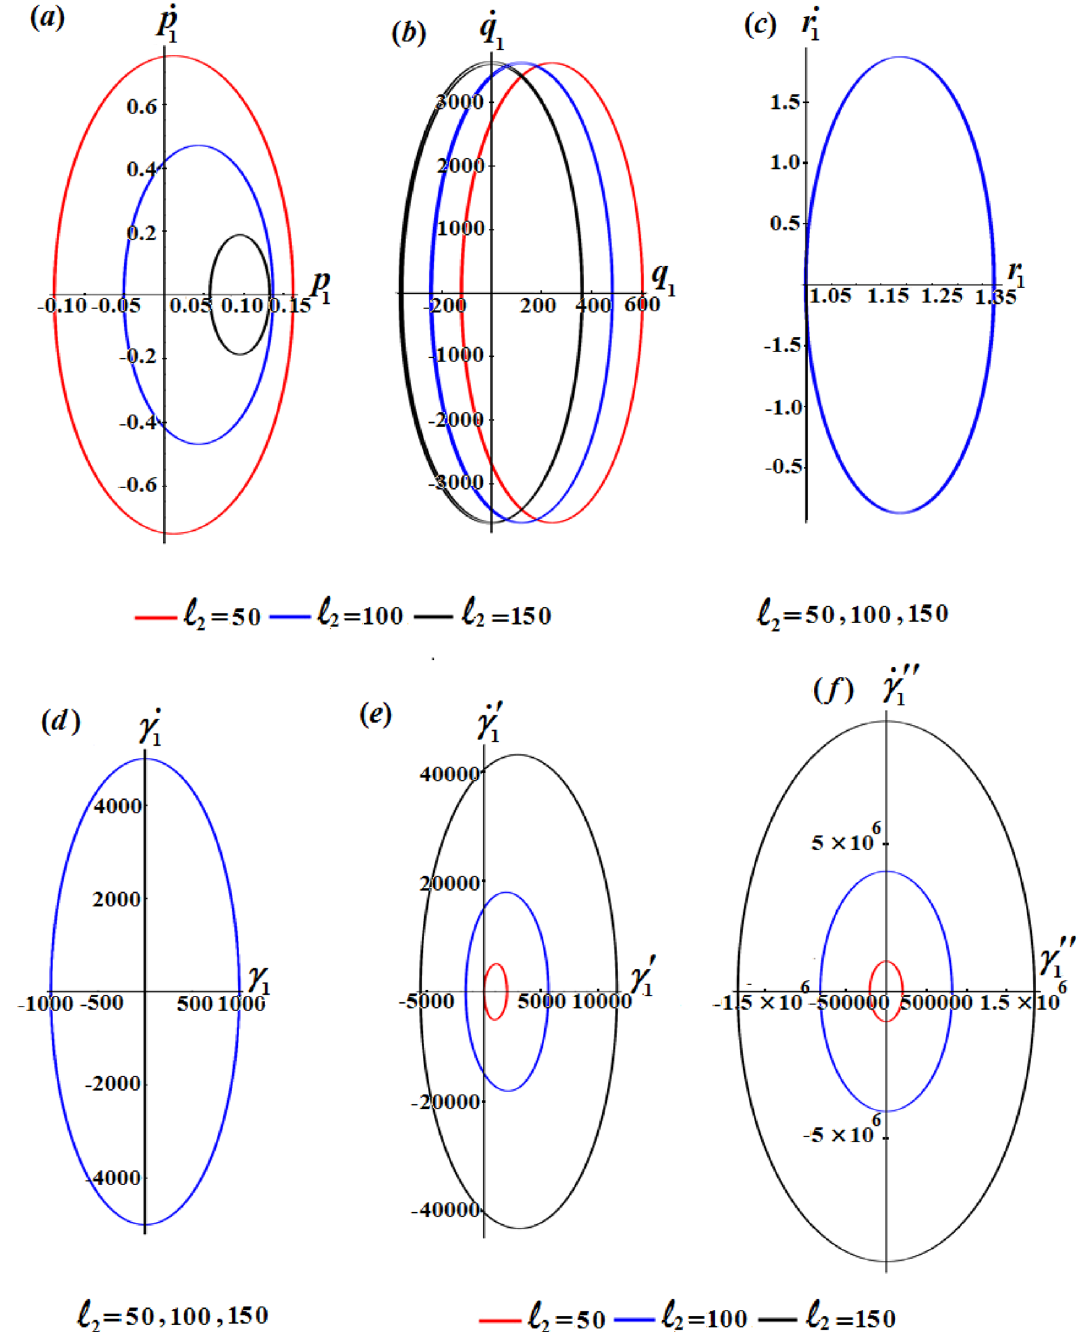
50, 100, 150 ) kg m 2 s − 1 =